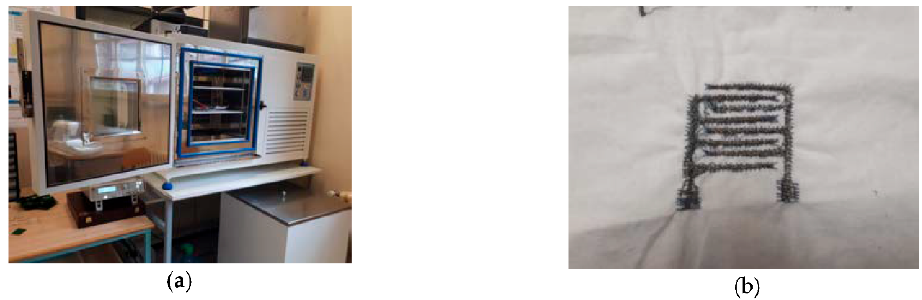
Figure 2. Image of the experimental setup. ( a ) climatic chamber, ( b ) embroidered short